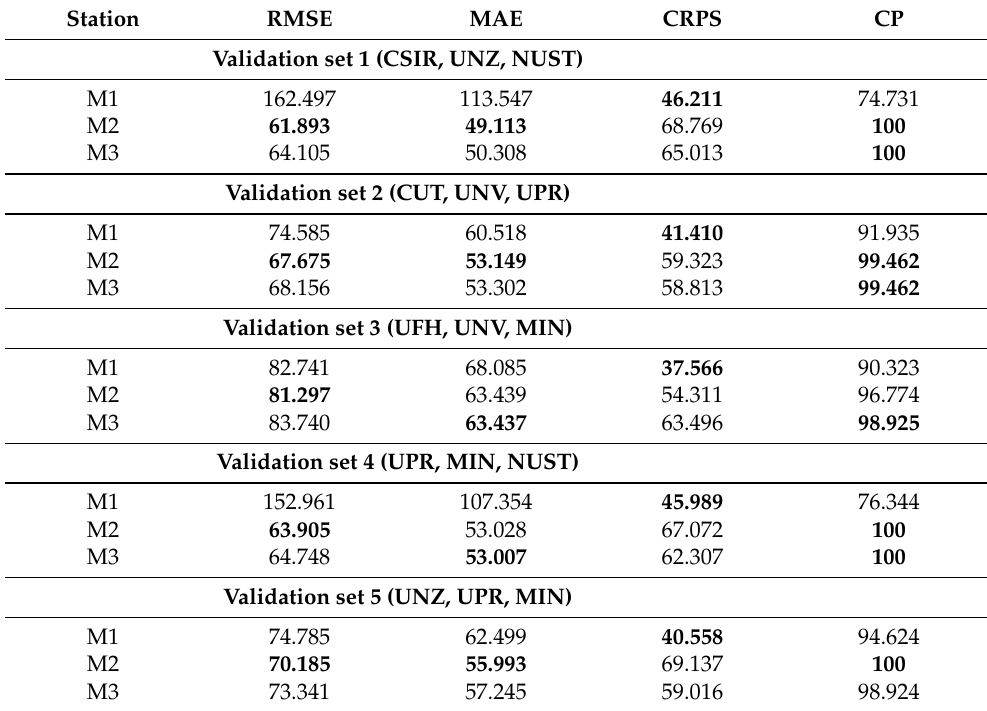
Table 5. Overall model evaluation for the three models.